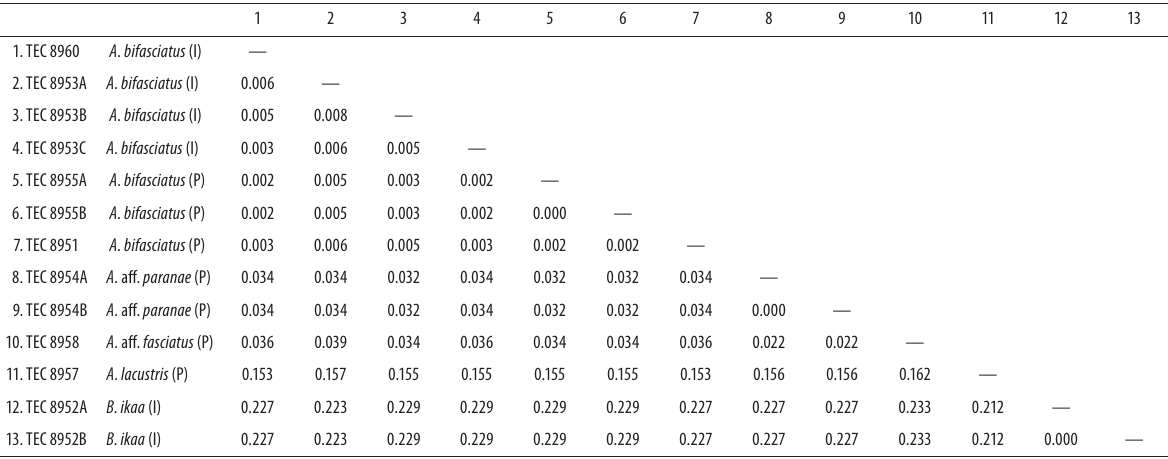
Table A2 . Pairwise distance between of the Astyanax bifasciatus specimens and other syntopic Characidae species from the basins of the lower Iguaçu River and Piquiri River (upper Paraná river basin) generated in this study. I = Iguaçu river basin, P = Piquiri river